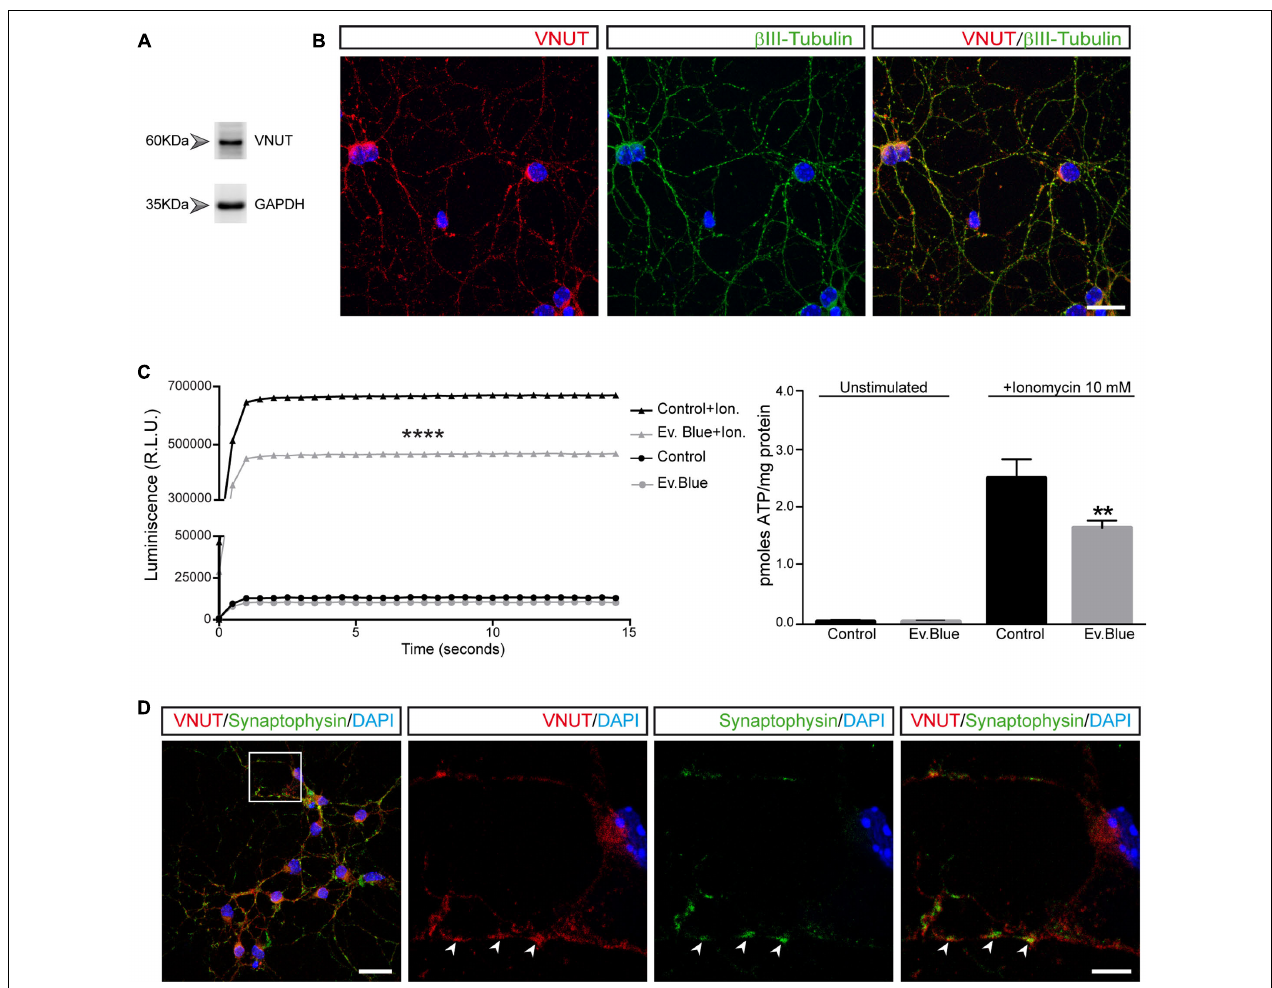
FIGURE 1 | Vesicular nucleotide transporter (VNUT) is expressed by cultured cerebellar granule cells. Identification of VNUT in granule cells by western blotting (A) and immunofluorescence (B) . Cells were stained with antibodies against VNUT (red) and β III-tubulin (green). Scale bar: 20 µ m. (C) ATP release to the extracellular medium by granule cells. The graph shows the luminescence values of cells maintained in the presence or absence of Evans Blue (2 µ M) and stimulated with ionomycin (10 µ M) or left unstimulated. The right graph represents the pmoles of ATP released per mg of protein in the different experimental conditions. The values represent the mean ± SEM ( n = 3: ∗∗ p < 0.01, ∗∗∗∗ p < 0.0001, unpaired Student’s t -test). (D) Representative confocal microscopy images of the immunostaining of granule cell neurons for VNUT (red) and synaptophysin (green). The nuclei are counterstained with DAPI (blue). Scale bar: 20 µ m. The inset represents a 4x magnification of the cell indicated. The arrows indicate the most prominent VNUT and synaptophysin positive vesicles. Scale bar: 5 µ